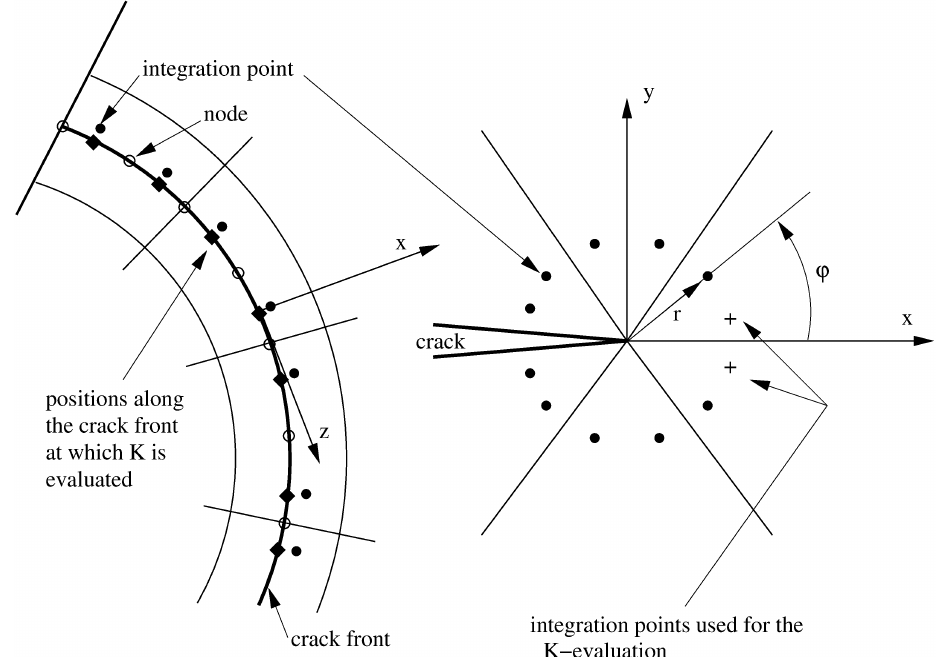
Figure 6. Local coordinate system at the crack